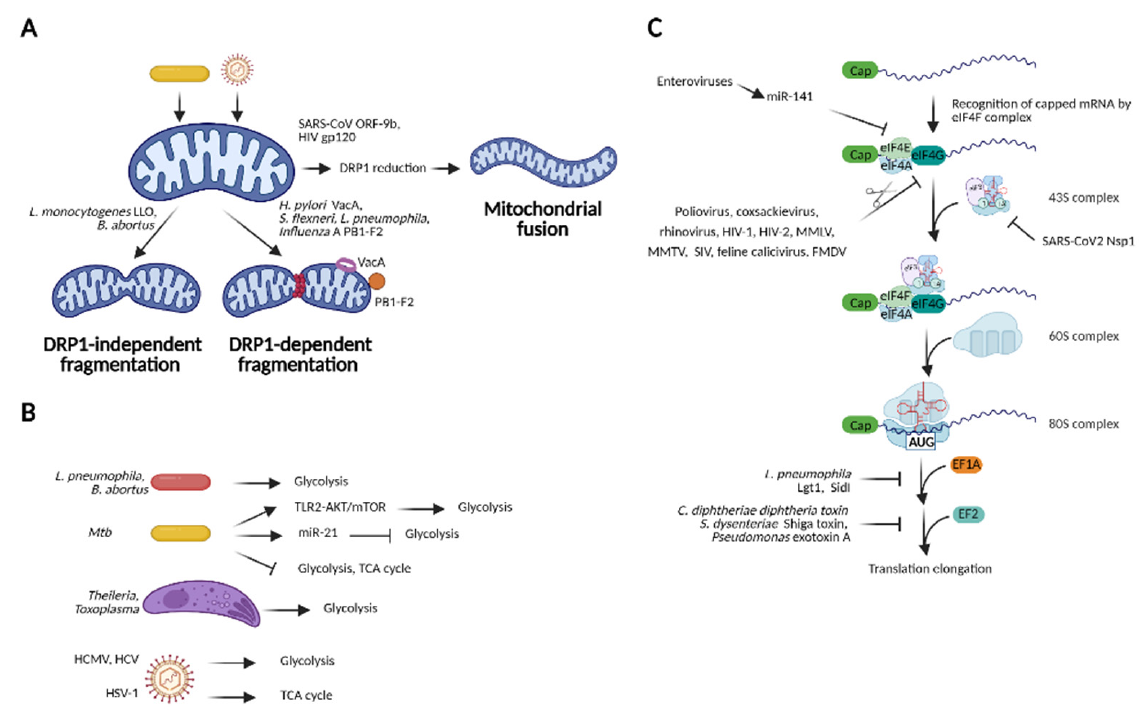
Figure 3. Mitochondrial dysfunction and blockade of host translation induced by pathogens. ( A ) Manipulation of mitochondrial dynamics by pathogens. Pathogenic viruses and bacteria cause mitochondrial fragmentation or mitochondrial fusion for replication, persistence in host cell or dissemination; ( B ) Modulation of host metabolism by pathogens. To acquire the nutrient from the host, pathogens trigger glycolysis or modulate the TCA cycle dependent on their metabolic requirements; ( C ) Inhibition of host translation by pathogens. To shut off host defense, many viruses such as poliovirus, coxsackievirus and rhinovirus, HIV-1, enteroviruses, and SARS-CoV2 target the eIF4F complex to inhibit translation initiation, while some bacterial pathogens utilize effector proteins or toxins to inactivate translation elongation factors-EF1A and EF2. Abbreviations: DRP1, dynamin related protein 1; VacA, vacuolating cytotoxin A; LLO, listeriolysin O; TLR2, toll-like receptor 2; AKT, protein kinase B; mTOR, mechanistic target of Rapamycin; TCA cycle, tricarboxylic acid cycle; HCMV, Human Cytomegalovirus; HCV, Hepatitis C Virus; HSV-1, Herpes simplex virus 1; HIV, Human immunodeficiency virus; MMLV, Moloney murine leukemia virus; MMTV, Mouse mammary tumor virus; SIV, Simian immunodeficiency virus; FMDV, Foot-and-mouth disease virus; eIF, eukaryotic translation initiation factor; EF1A/1B, eukaryotic translation elongation factor 1A/1B; Lgt1, Legionella glucosyltransferase 1; SidI, substrate I of Icm/Dot transporter; Nsp1, nonstructural protein 1. Image created with BioRender.com .